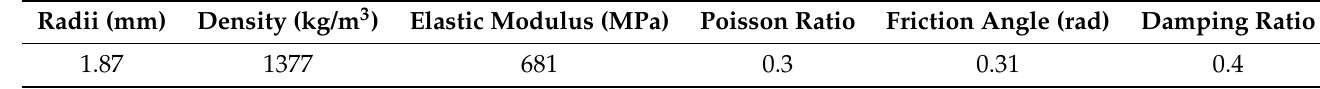
Table 1. Coke properties which are used in the discrete element method (DEM) model [5]. Radii (mm)